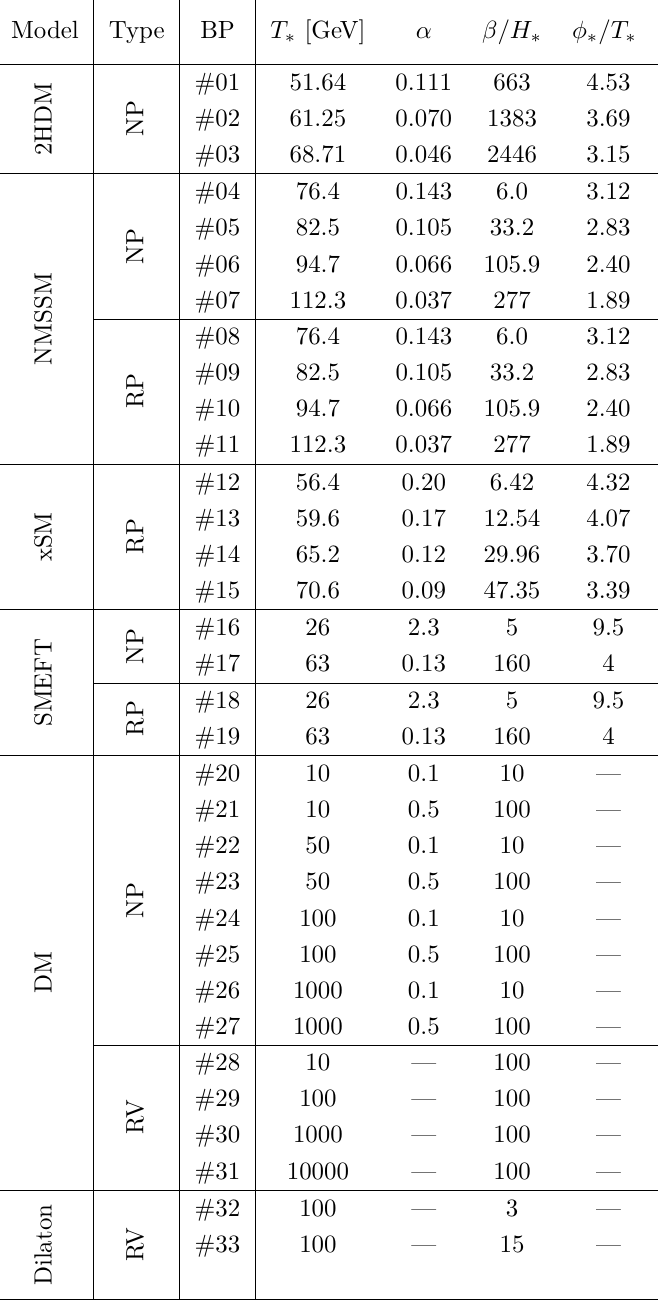
Table 1 . BSM models and benchmark points used in our model comparison in section 3.3. See